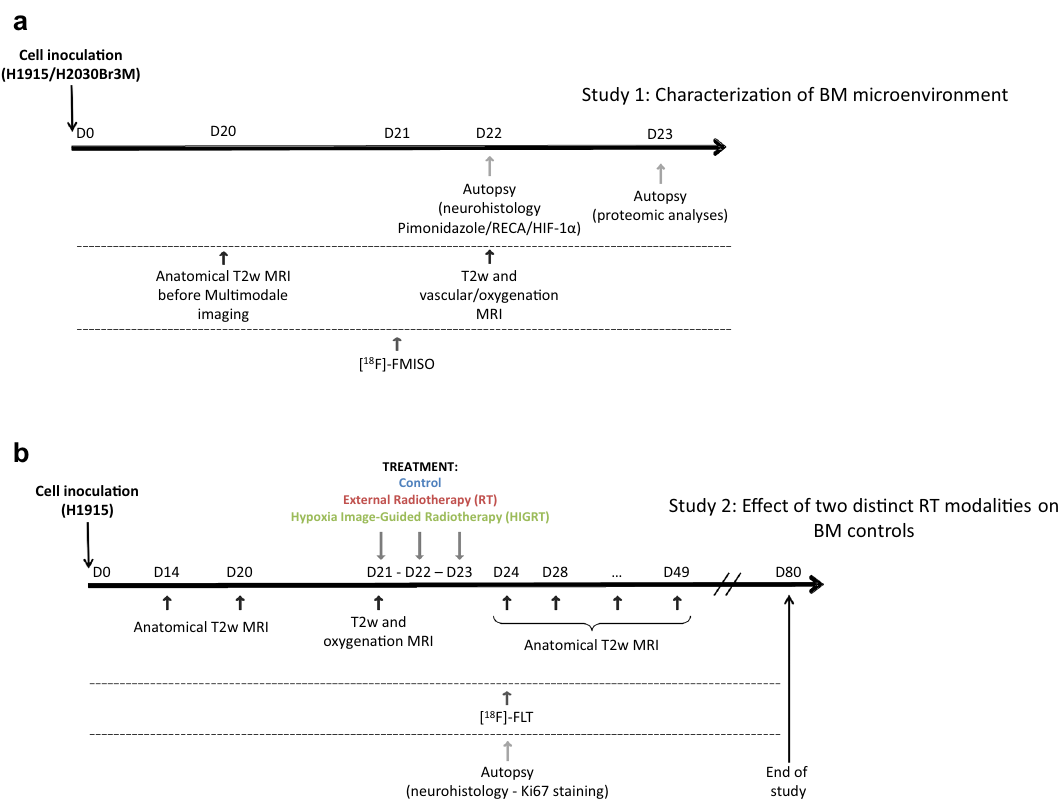
Figure 1. Experimental paradigm and schema for ( a ) hypoxia microenvironment characterization study and ( b ) therapy